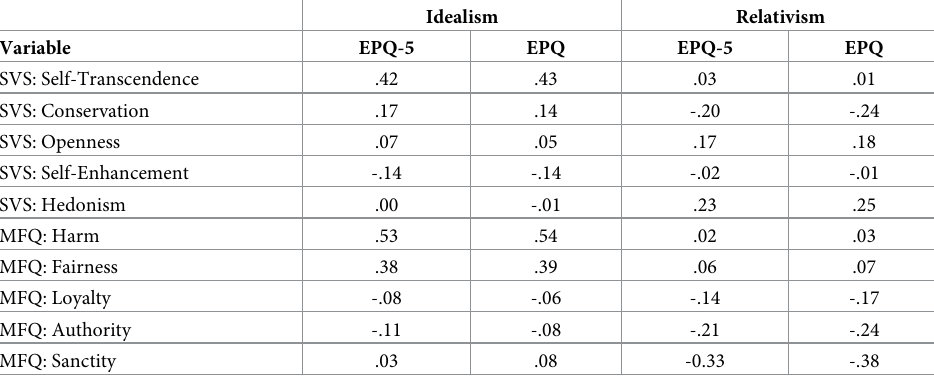
Table 6. Correlational comparison of the original EPQ and the revised EPQ (EPQ-5) in predicting associations with moral values (SVS: Schwartz Value Scale) and moral foundations (MFQ: Moral Foundations Questionnaire). Idealism